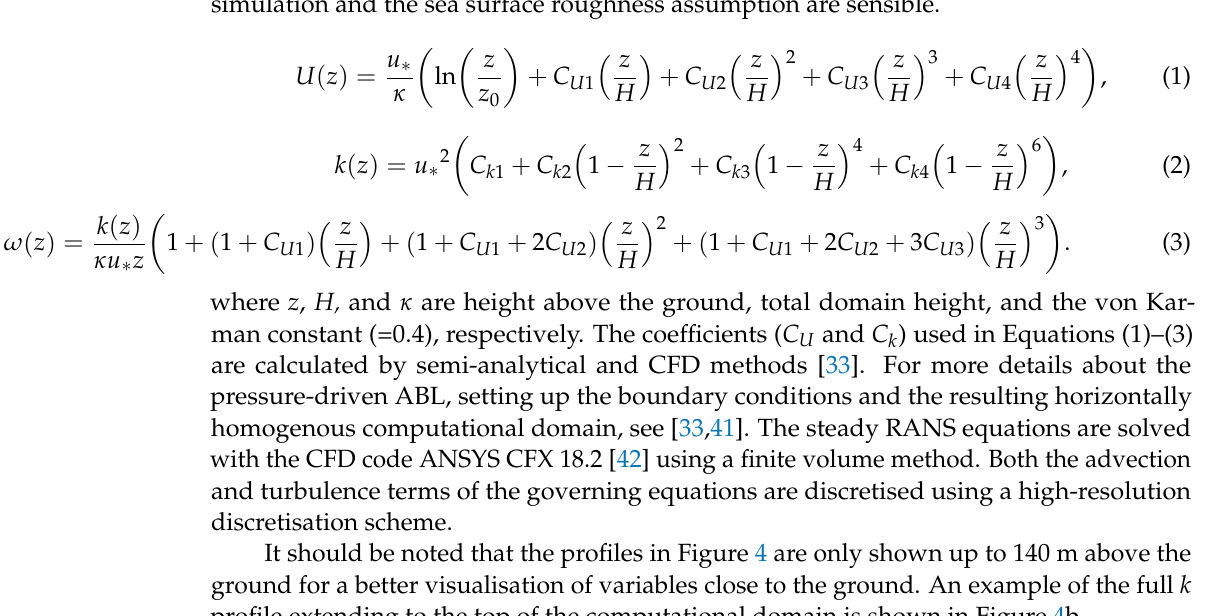
Figure 4. Inlet profiles for the CFD simulation: ( a ) mean speed; ( b ) turbulent kinetic energy; ( c ) turbulent eddy frequency. The smaller graph in the top right of ( b ) shows the k profile extending to the top of the domain.